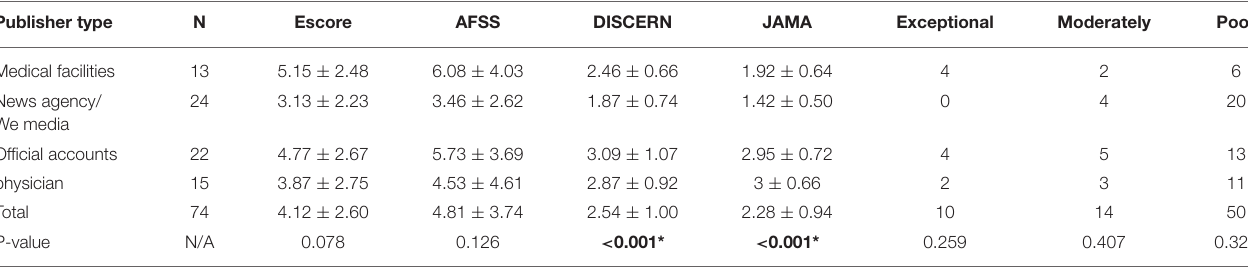
TABLE 4 | Escore, AFSS, JAMA Score, and DISCERN values categorized by video publisher type on